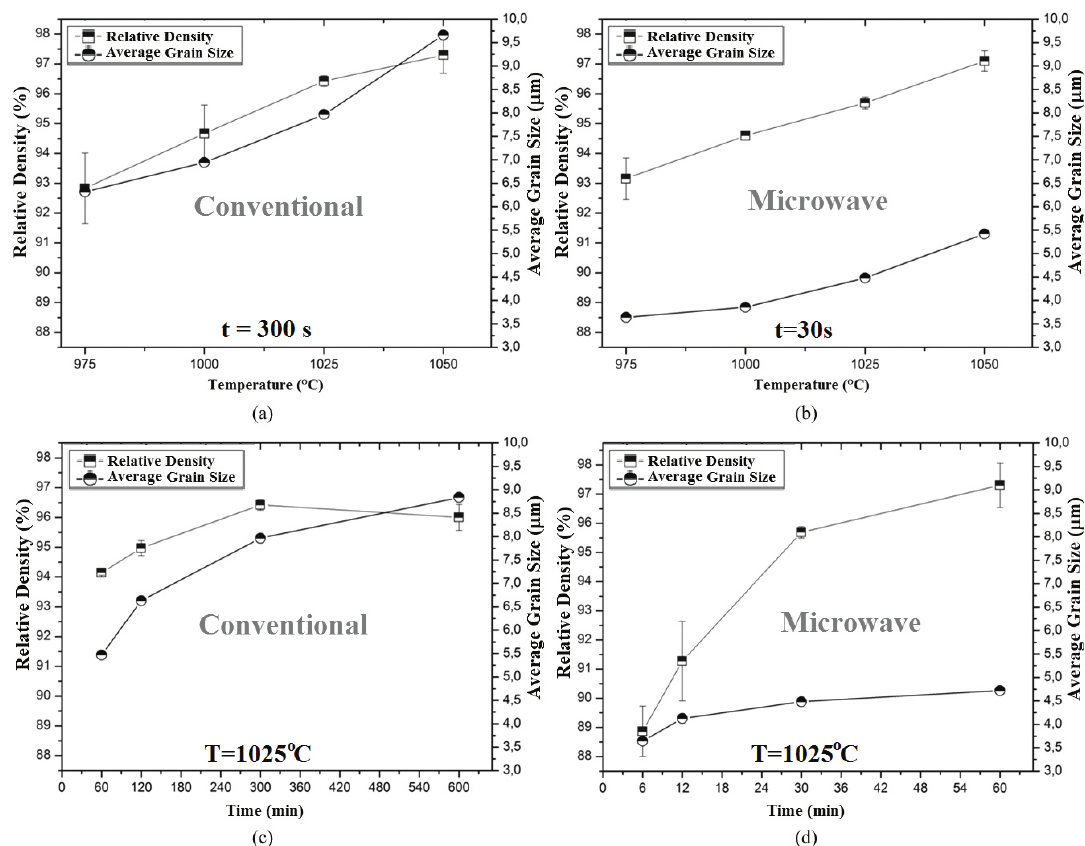
Figure 4. Dependence of relative density and average grain size with: i) temperature in (a) conventional heating and (b) microwave heating; ii) dwell time in conventional heating (c) and microwave heating